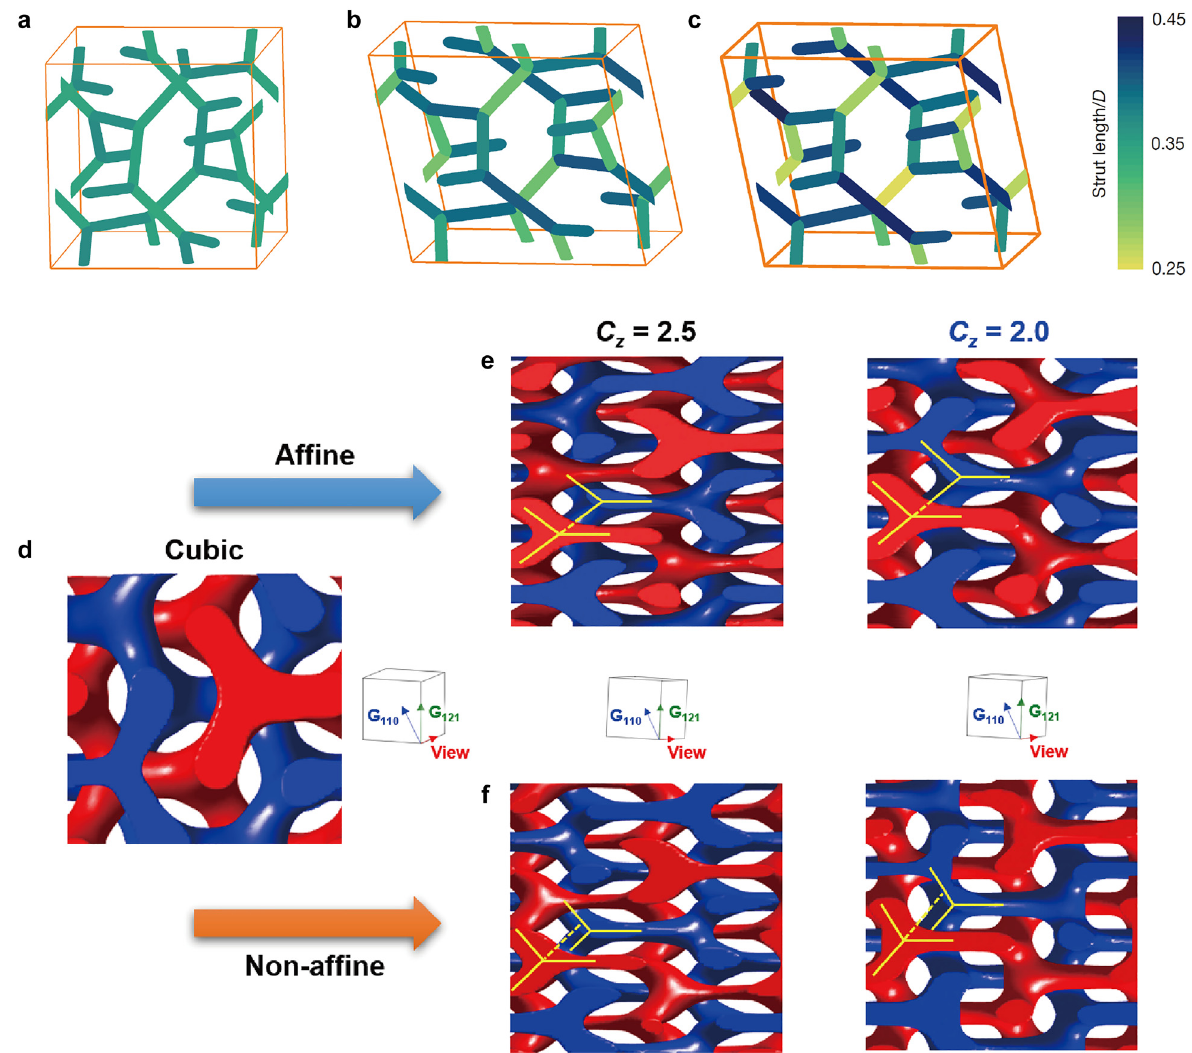
Figure 9: Structural characteristics of BCP gyroids in cubic, affine, and non-affine structures. (a) – (c) Skeletal graphs for (a) cubic, (b) affine, and (c) non-affine gyroid models derived from self-consistent field calculations. (d) PS-free (PMMA-channels) electron-density difference ( Δ ρ ) map of cubic double-gyroid structure. (e) Simulated af fi ne and (f) experimental non-af fi ne maps for gyroid structures with z -directional contraction ratio ( C z ) of 2.5 and 2.0. Reproduced with permission from ref. [56]. Copyright 2019, Nature Portfolio (a) – (c); reproduced with permission from ref. [35]. Copyright 2021, Elsevier B.V. (d) –